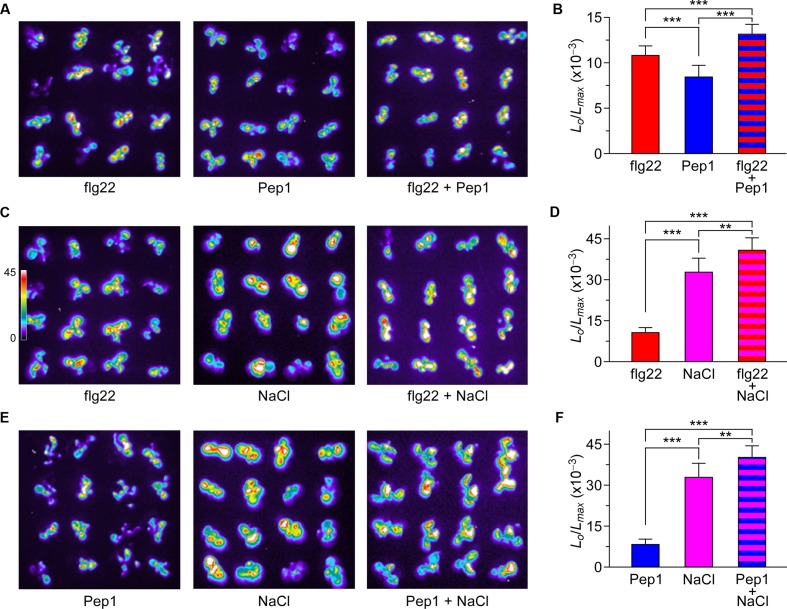
Increases in [Ca2+]i in response to flg22, Pep1, and NaCl individually or combined.
(A) Imaging of [Ca2+]i increases in response to the treatments of 1 μM flg22, 1 μM Pep1, and together. (C) Imaging of [Ca2+]i increases in response to the treatments of 1 μM flg22, 200 mM NaCl, and together. (E) Imaging of [Ca2+]i increases in response to the treatments of 1 μM Pep1, 200 mM NaCl, and together in Arabidopsis seedlings expressing aequorin. All images were taken for 420 s, and [Ca2+]i increases were analyzed by imaging bioluminescence and scaled by a pseudo-color bar. (B,D,F) Quantification of [Ca2+]i increases from experiments as in (A,C,E). Data for four independent experiments are shown (mean ± SD; n = 16; ∗∗∗P < 0.001; ∗∗0.001 < P < 0.01; NS, not significant P > 0.05).